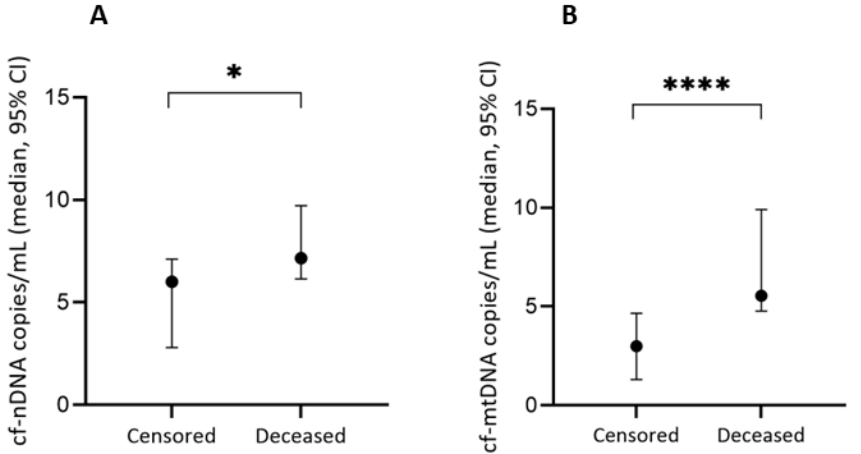
Figure 1. The association between the median copy number of saliva-based ( A ) cf-nDNA and ( B ) cf- mtDNA with the status of the patients (censored vs. deceased). Data are shown as mega copies/mL. * p < 0.05, **** p < 0.0005.